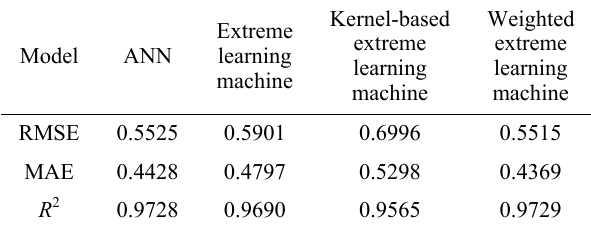
Table 7 Performance evaluation of the designed machine learning